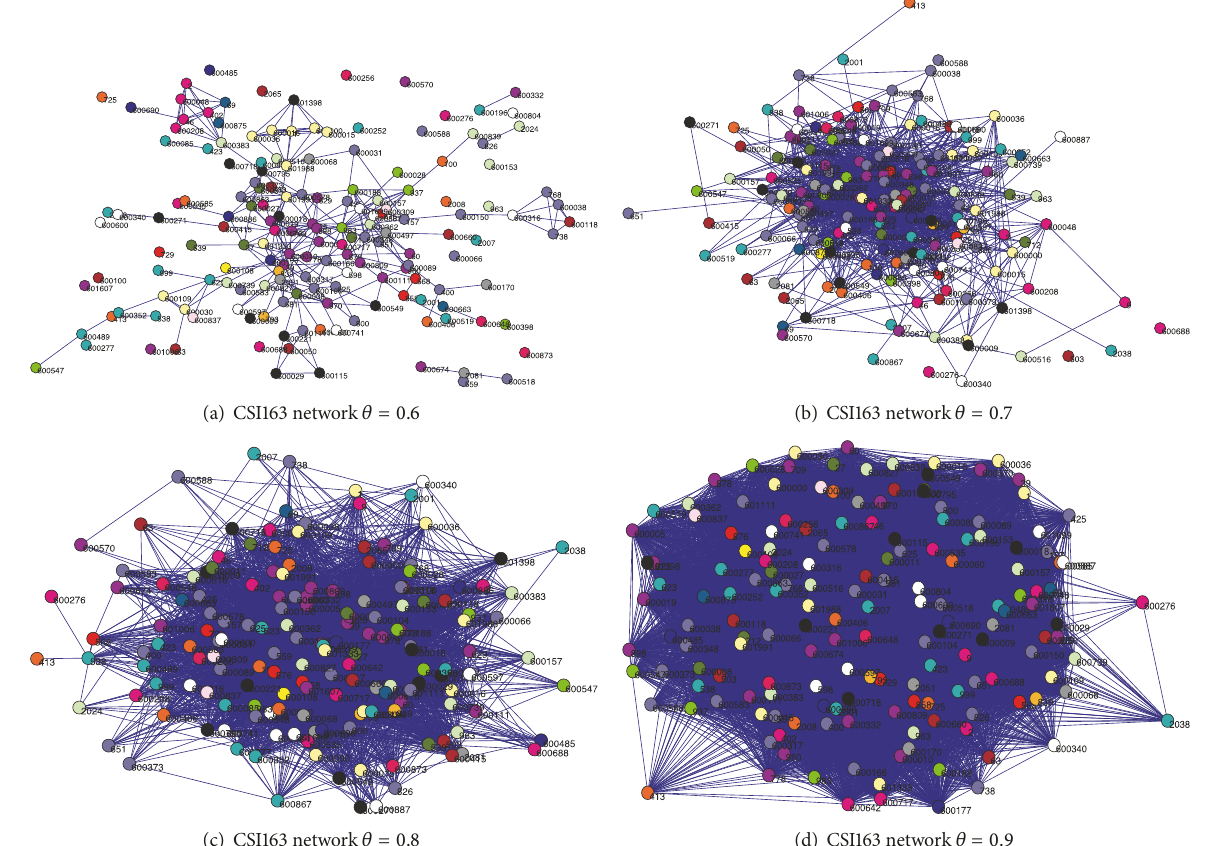
Figure 7: CSI163 networks with different 𝜃 of 0.6 (a), 0.7 (b), 0.8 (c), 0.9 (d). It shows that the network is relatively sparser with small 𝜃 while denser with large 𝜃 , for small 𝜃 greatly simplifies the network by filtering most edges with larger distance. As a result, the edge density when 𝜃 = 0.9 is about 38.25 times to that when 𝜃 = 0.6 . Different vertex colors indicate different industry sectors.